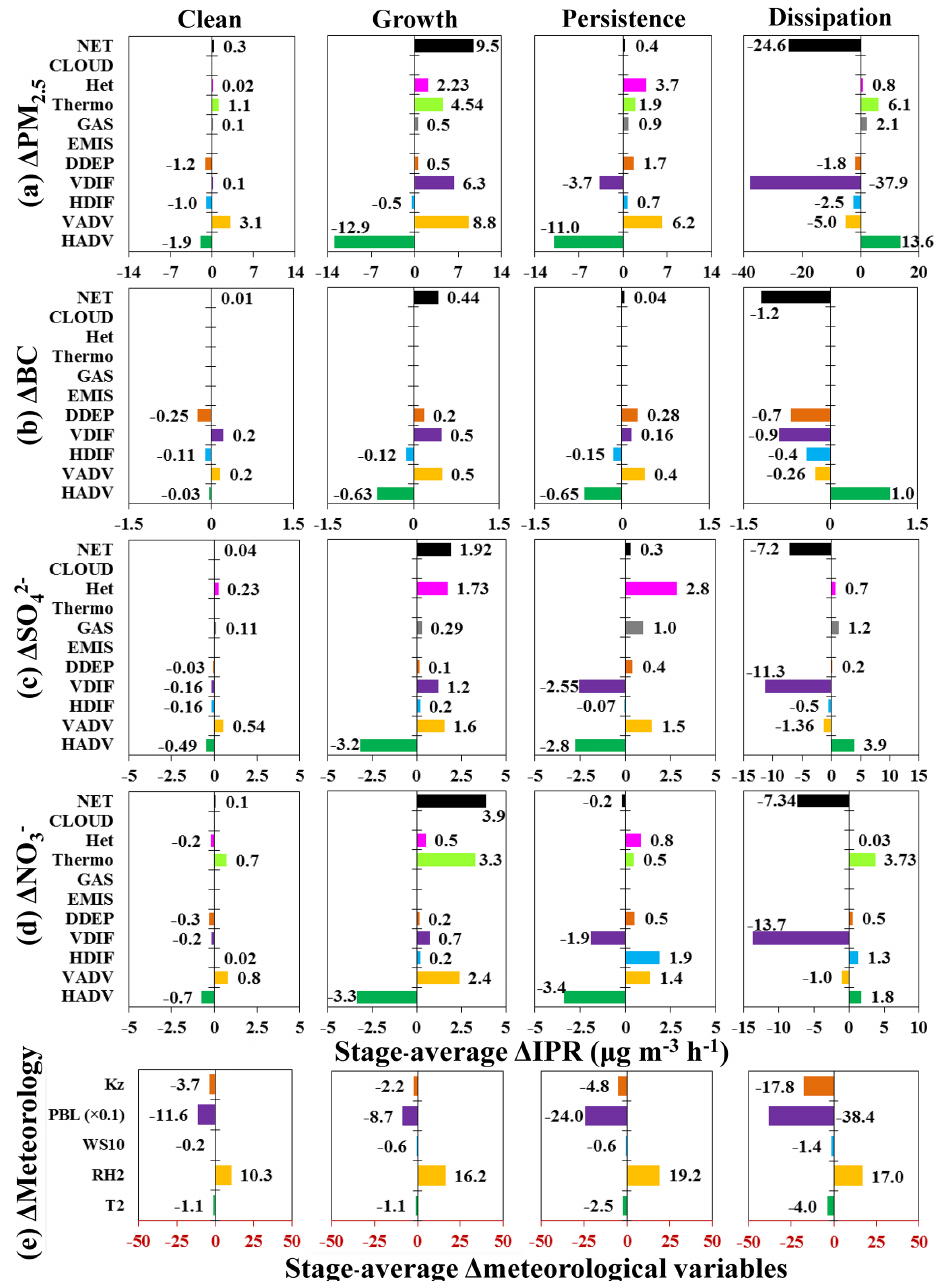
Figure 10. The feedback-induced mean changes in IPRs (FULL minus NoAFB) for PM 2 . 5 and its chemical components and meteorological variables during the first haze episode (20–26 February) in Beijing. (cid:49) IPRs for PM 2 . 5 and its chemical components and (cid:49) meteorological variables are averages over the four stages. Note that zero (cid:49) IPR values (no change) are not shown and the (cid:49) PBL heights are scaled by 0.1. The division of the four stages and the units are the same as those in Fig.